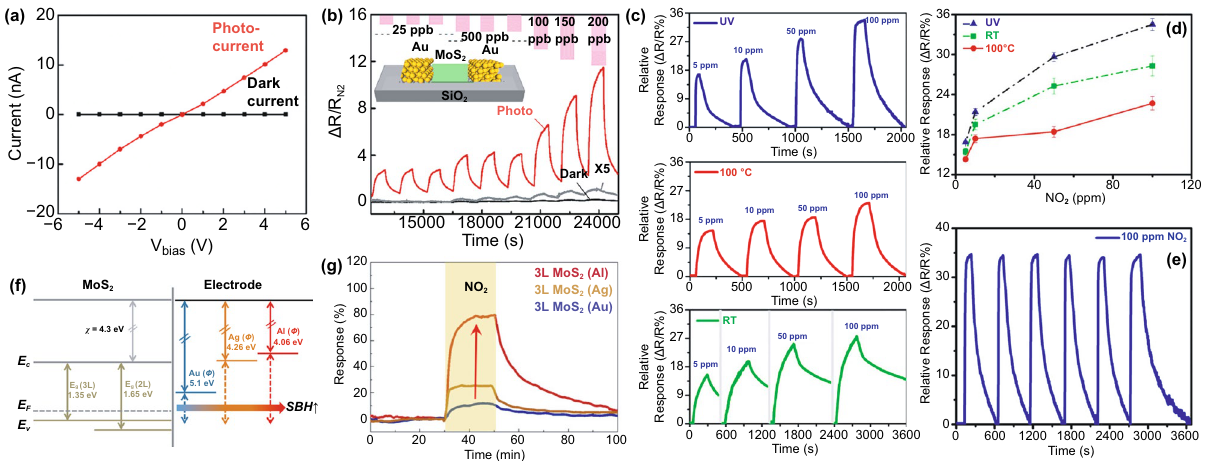
Fig. 19 a I–V dependence of the Au–MoS 2 –Au device in the dark and under red LED illumination with incident power of 60.9 nW. b Effect of NO 2 gas exposure at concentrations from 25 to 200 ppb on normalized resistance of the Au–MoS 2 –Au device in the dark (black line; gray line shows fivefold magnified data) and under red LED illumination (red curve). Reproduced from Ref. [240] with permission. Copyright 2019, American Chemical Society. c Transient relative response of sensor to 5, 10, 50, and 100 ppm concentration of NO 2 at room temperature (RT), at 100 °C, and at RT under UV illumination (1.2 mW cm −2 ). d Relative response versus NO 2 concentration at RT, 100 °C, and at RT under light. e Cyclic test to 100 ppm of NO 2 at RT under UV light. Reproduced from Ref. [241] with permission. Copyright 2017, American Chemical Soci- ety. f Band diagram of MoS 2 with metal electrodes. g Sensing characteristics of NO 2 for 3L MoS 2 with Al, Ag, and Au electrodes. Reproduced from Ref. [243] with permission. Copyright 2019, American Chemical